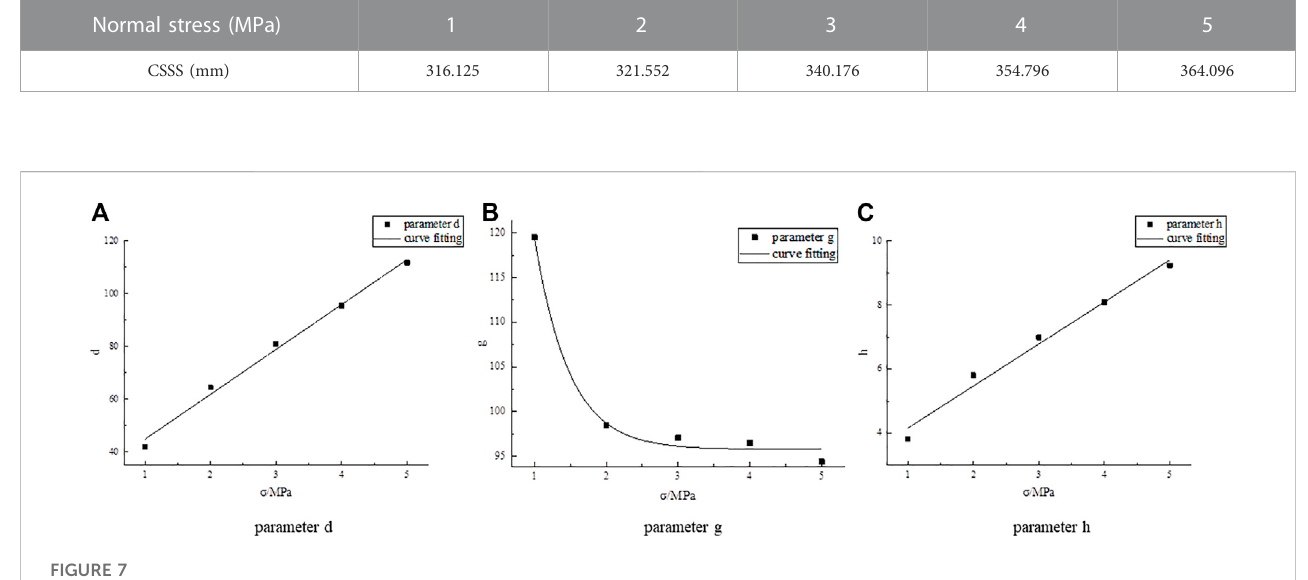
FIGURE 7 Fitting curve diagram of the parameters.